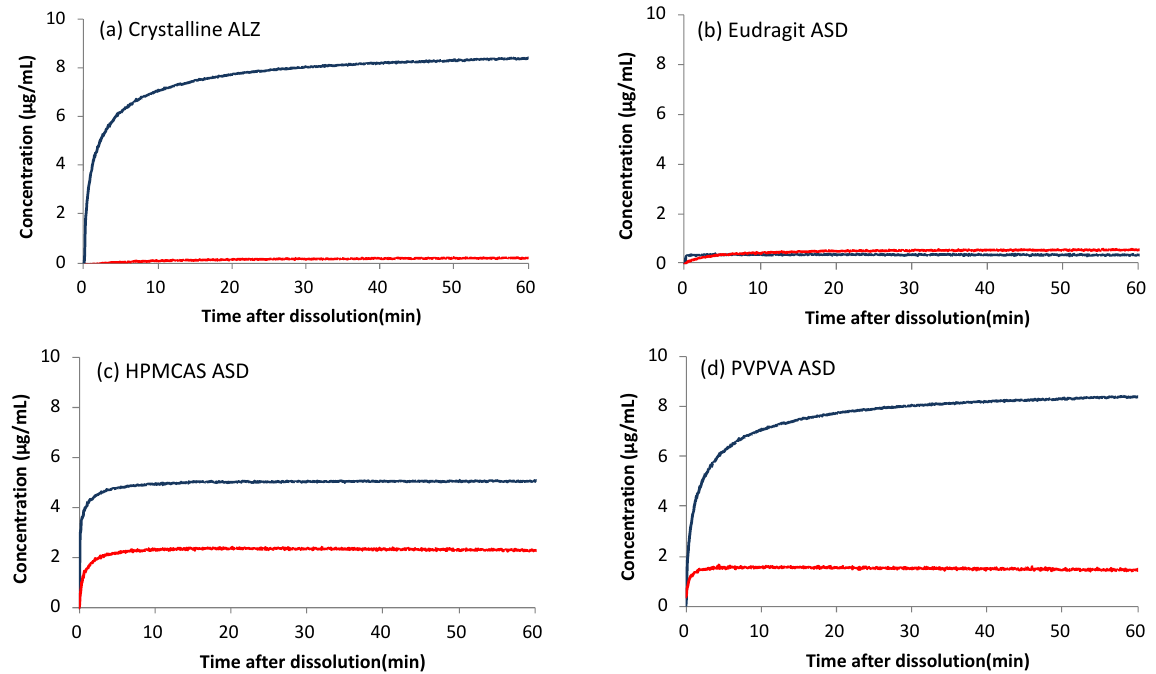
Figure 5. µ Diss dissolution test of ( a ) crystalline ALZ and ( b – d ) ALZ ASDs. Types of polymers are indicated in the figure. Blue and red lines represent dissolution profiles in JP1 (pH 1.2) and JP2 (pH 6.8) solutions.